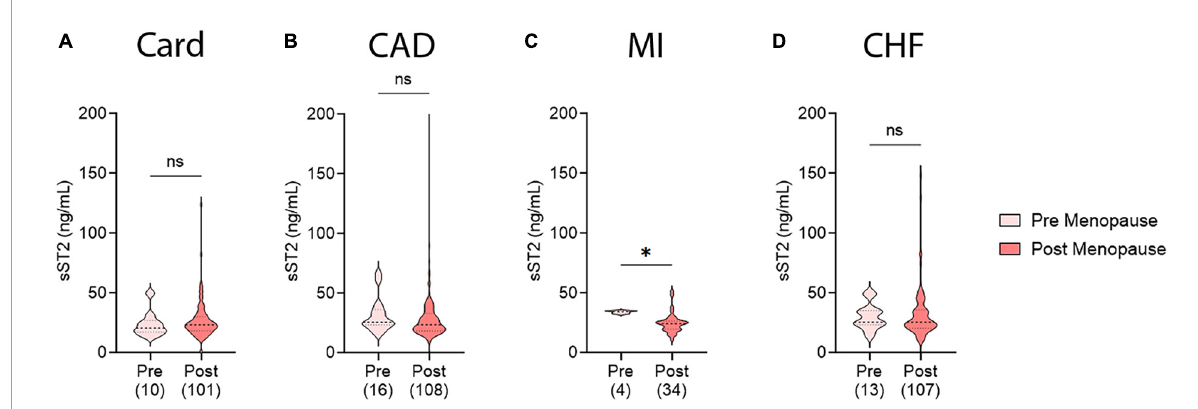
FIGURE4 Soluble ST2 (sST2) in pre- vs. post-menopausal women with CVDs. sST2 levels compared pre-menopausal women (light peach) to post-menopausal women (dark peach) for (A) cardiomyopathy (Card), (B) coronary artery disease (CAD), (C) myocardial infarction (MI), or (D) congestive heart failure (CHF). Violin plots denote data distribution for each group with p- value calculated using unpaired Student’s t -test: *, p < 0.05; ns, not significant.